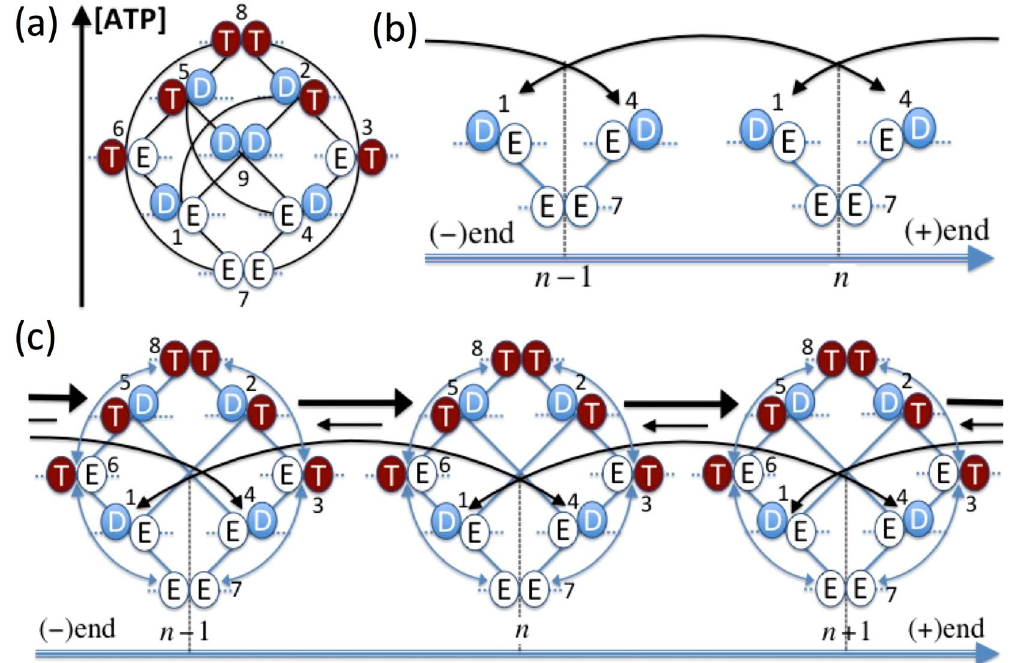
Figure 1. ( a ) Kinesin state space consisting of 3 2 = 9 chemical states and 18 chemical transitions between these states 33 , ( b ) a three-state model for ATP-free force-assisted passive bidirectional movement of kinesin at finite ADP concentrations, and ( c ) an eight-state chemomechanical network model of kinesin. In these figures, kinesin heads with ATP and ADP bound are denoted by T and D, respectively, and empty heads are denoted by E. Both the T and E states are strongly bound to an MT, whereas the D state is weakly bound 25, 41, 42 . The vertical displacements of the heads with the D state from the baseline indicate their weak binding. In Fig. 1a, the left axis schematically indicates that the appearance probability of each state qualitatively depends on the ATP concentration. In the absence of ATP (Fig. 1b), kinesin’s movement is always a symmetric random walk irrespective of ADP concentration, as long as no external force is applied. In Fig. 1c, the weakest binding state, state 9 (DD), contributes neither a mechanical step transition nor supports staying on an MT, so it is eliminated from the full state space shown in Fig. 1a, while all possible chemical and mechanical transitions among the other eight states are taken into account. Detachment of kinesin from the MT is assumed to occur via states 2 (DT), 5 (TD), 1 (DE), and 4 (ED) that are related to the mechanical step (see “Calculation details” of the Method section and Supplementary